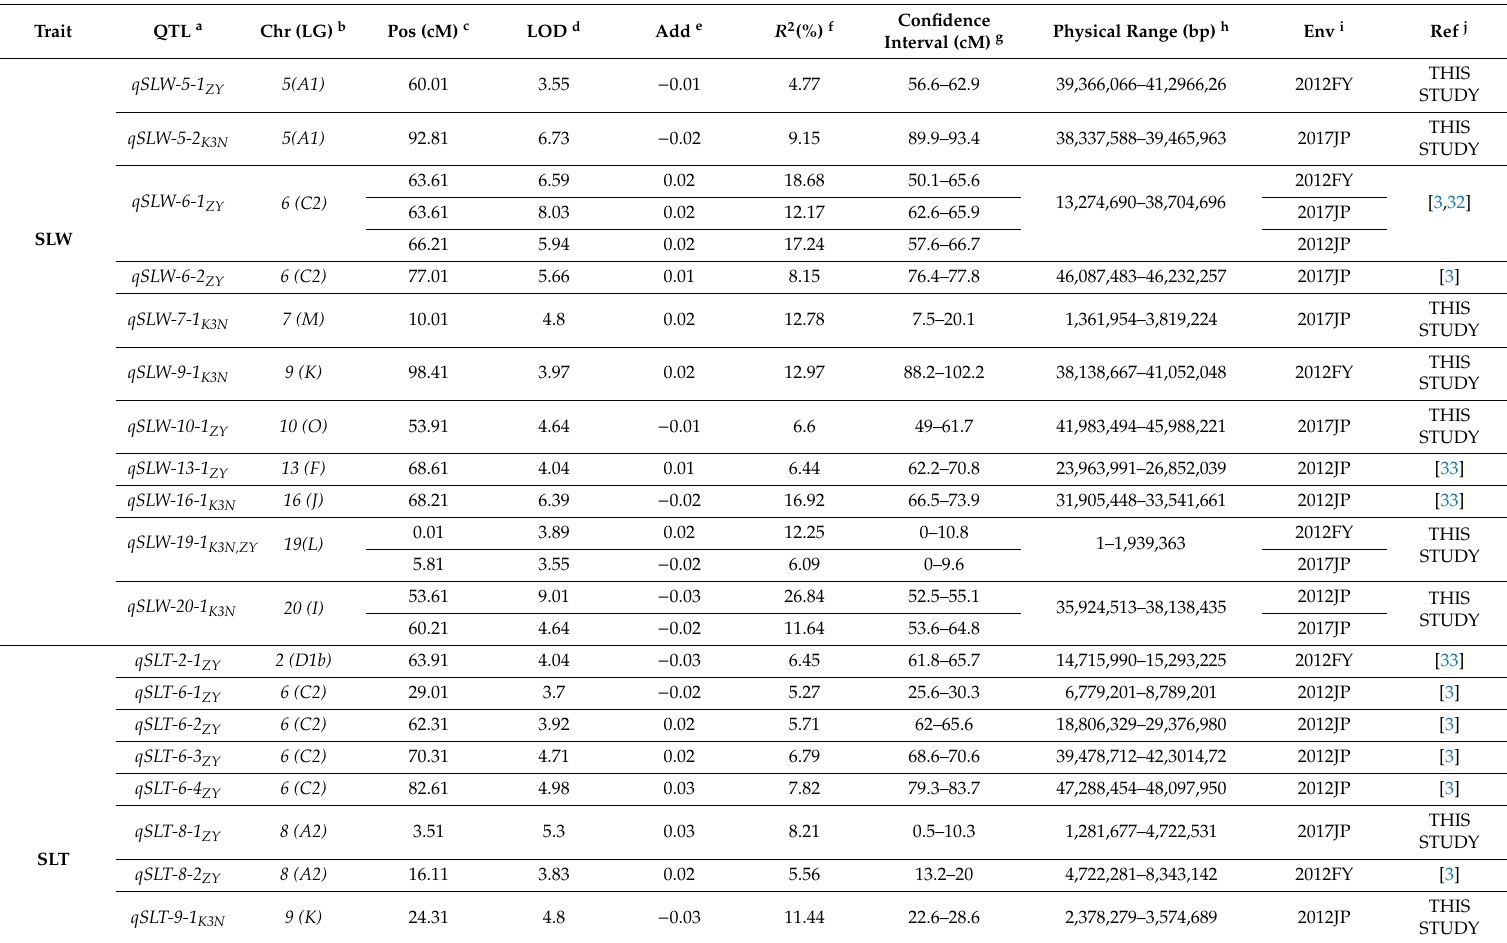
Table 2. M-QTLs identified for three seed-shape traits (seed length-to-width (SLW), seed length-to-thickness (SLT), and seed width-to-thickness (SWT)) in ZY and K3N RIL populations across multiple